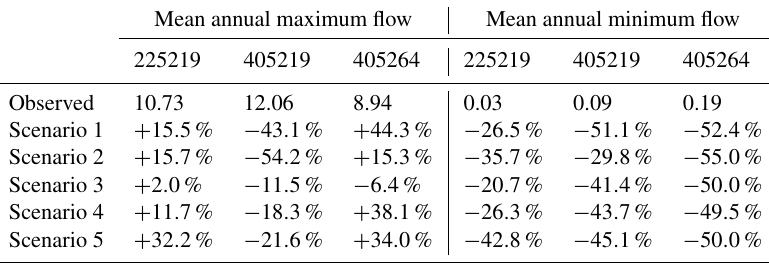
Table 7. Comparison of the projection performance of median flows during the verification period associated with the mean annual maximum in the wet years. The percentage represents the percentage of variation between the modeled value and the observed